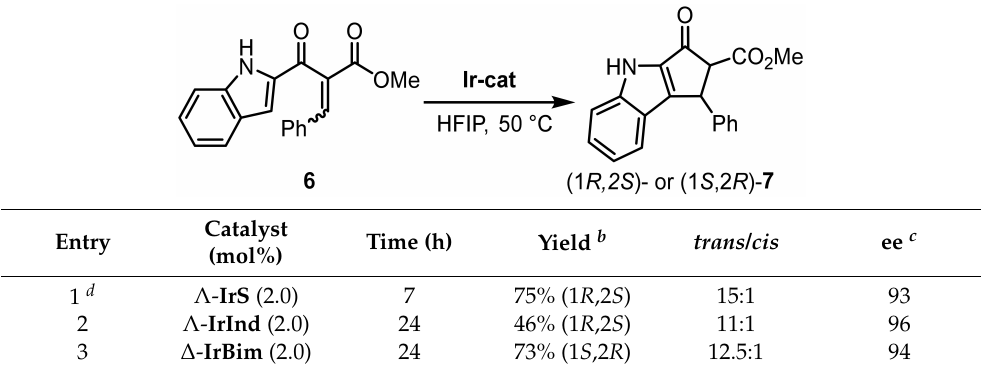
Table 2. Catalytic asymmetric Nazarov cyclization a